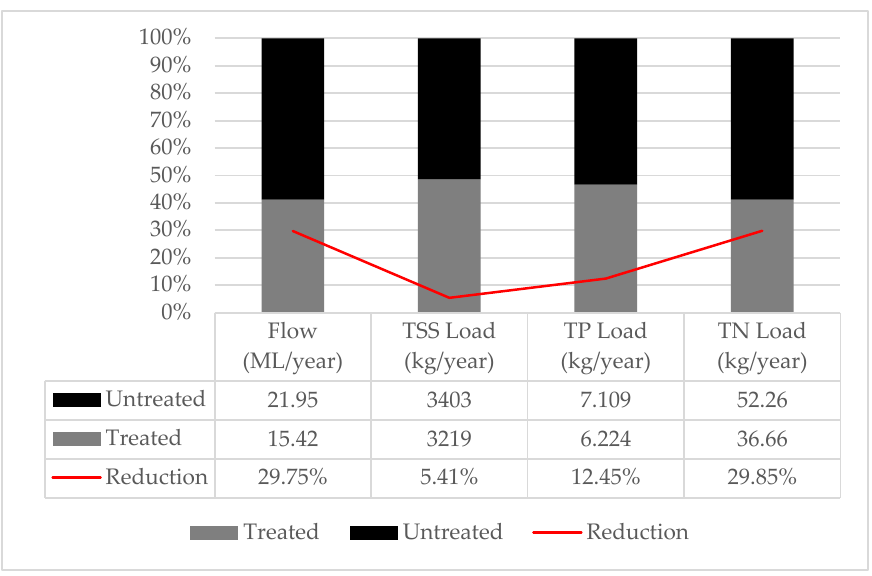
Figure 9. Green roof treatment effectiveness based on the bioretention node approach.